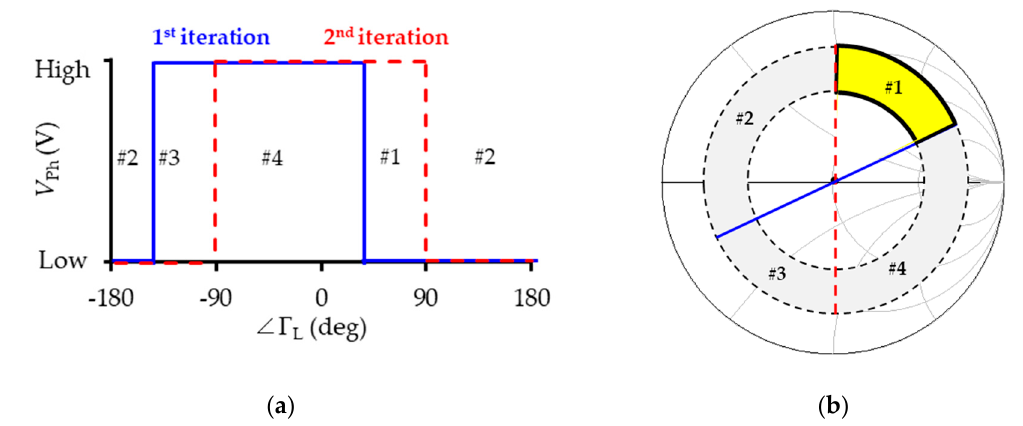
Figure 4. ( a ) Proposed mismatch impedance detector; ( b ) block diagram of phase detector; ( c ) simulated V diff , V ref and V ph ; ( d ) reconfigurable phase shifter configuration; ( e ) simulated V diff , V ref and V ph for two phase values of phase shifter.